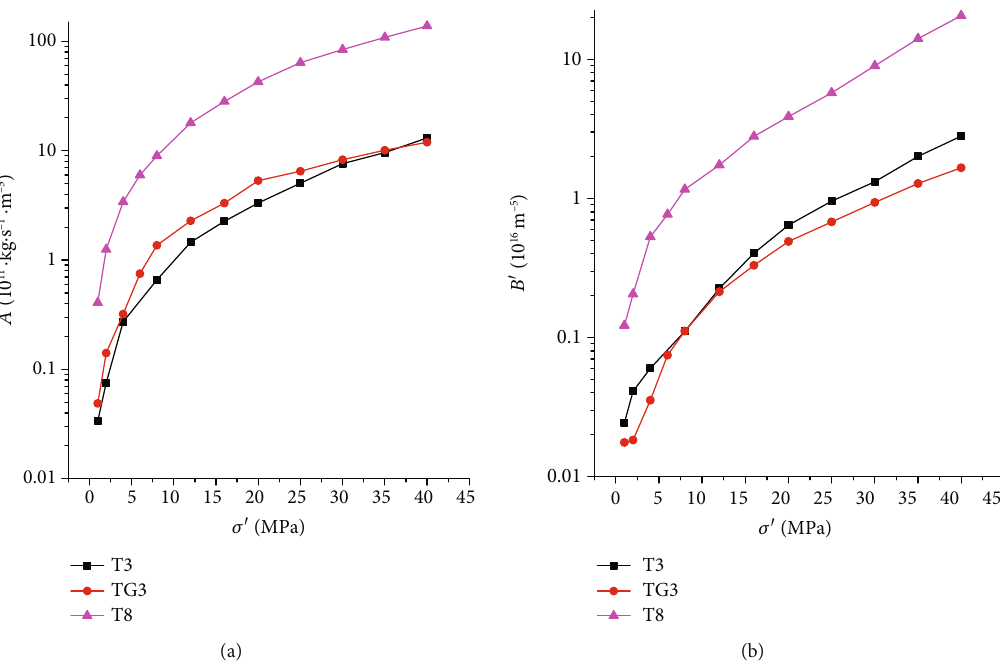
Figure 7: Relationship between e ff ective con fi ning stress and coe ffi cients (a) A and (b) B ′ .